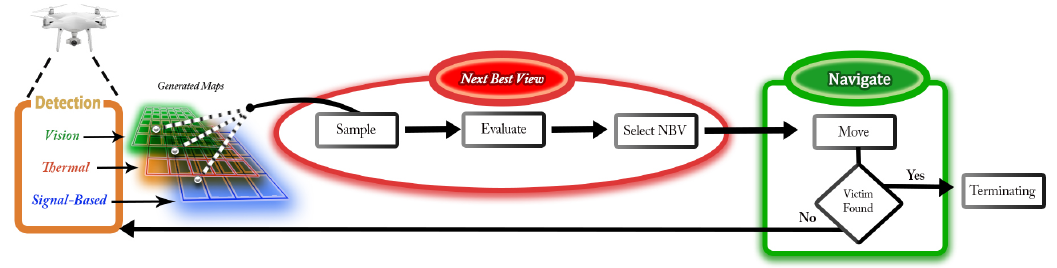
Figure 2. Flowchart of the System